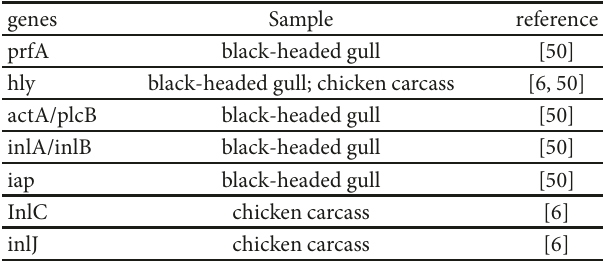
Table 1: Specific genes used to determine the virulence of L.